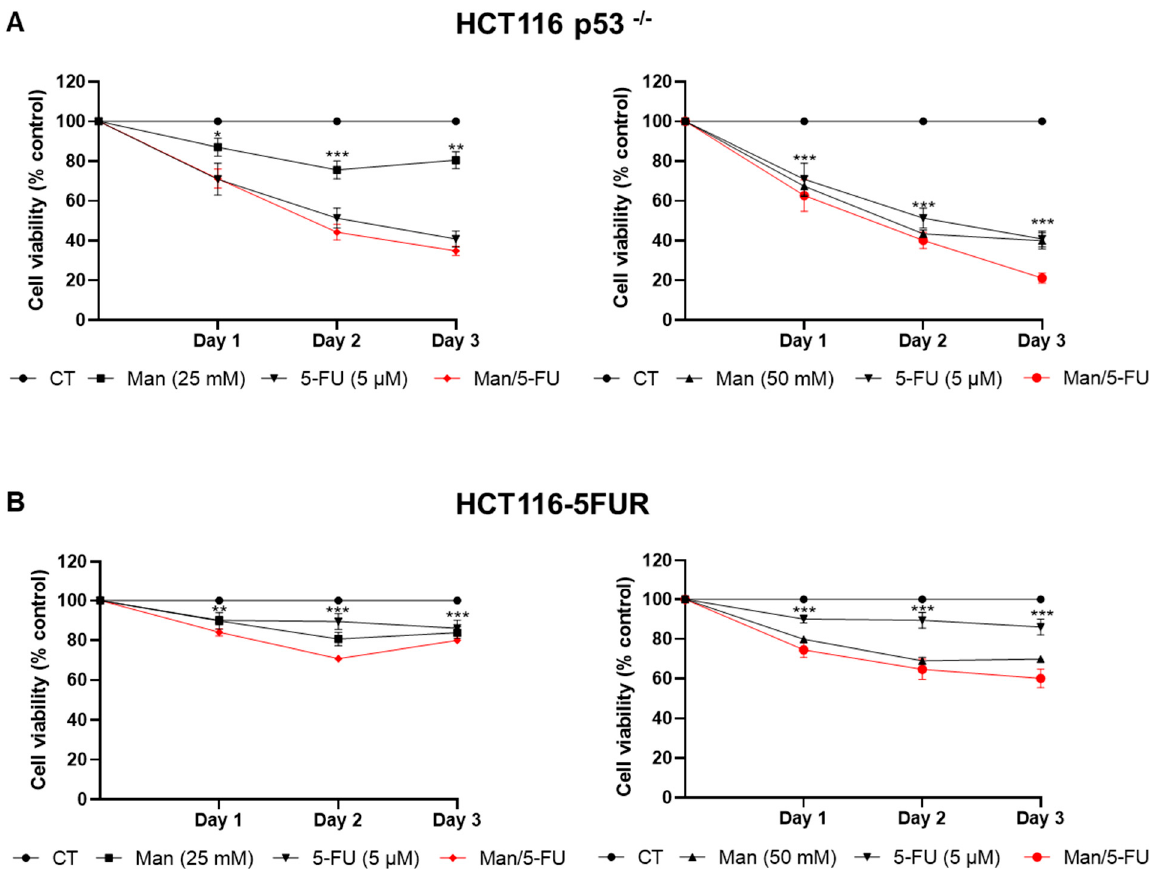
Figure 4. Mannose and 5-FU combination treatments sensitize the human colorectal cancer cells rela-